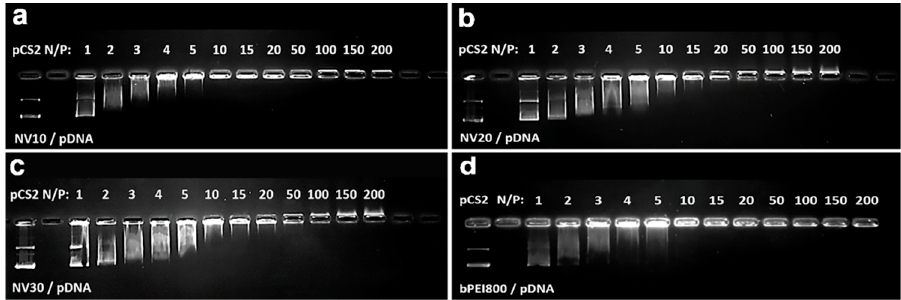
Figure 4. Electrophoretic mobility of polyplexes formed by complexation of pDNA and NV10, NV20, NV30 at various N / P ratios. ( a ) NV10 / pDNA, ( b ) NV20 / pDNA, ( c ) NV30 / pDNA and ( d ) bPEI800 / pDNA.